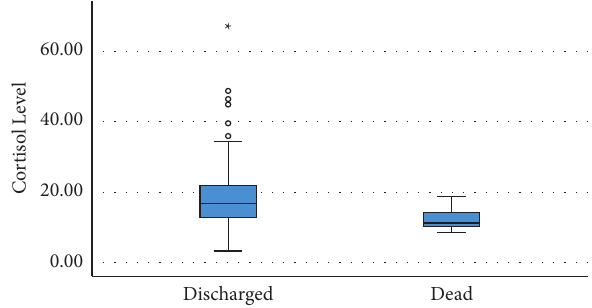
Figure 1: Distribution of cortisol levels in the two groups (dis- charged vs. dead